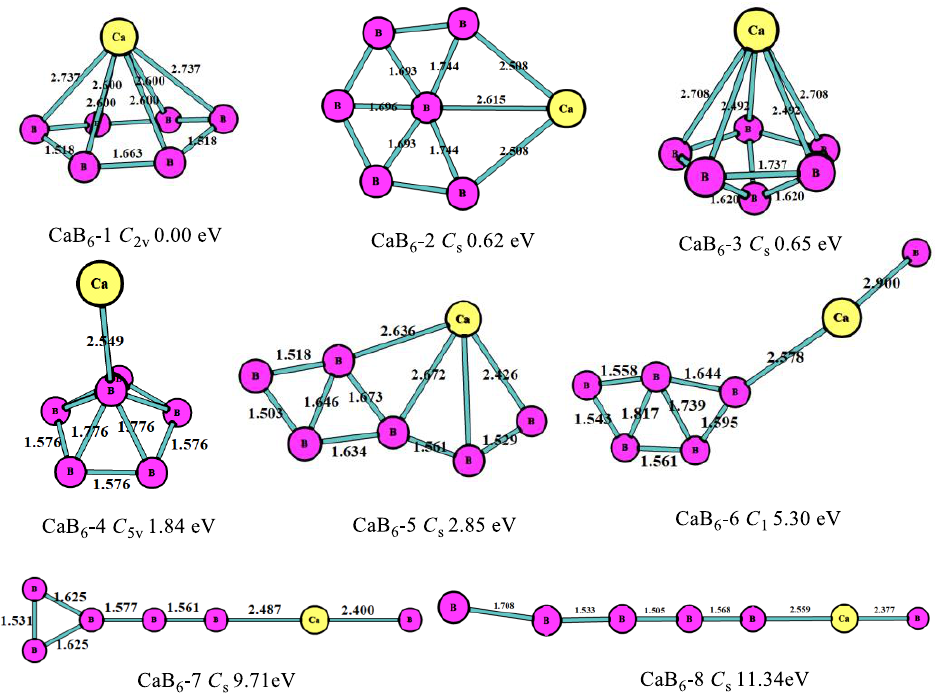
Figure 4. The geometry structures of the CaB 6 clusters obtained MP2/6-311+G(d)//B3LYP/6-311+G(d). The bond length unit is Å .